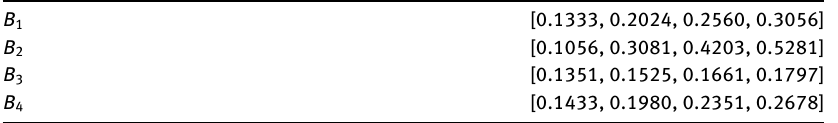
Table 12: Trapezoidal Fuzzy Weighted Averaging Operator.